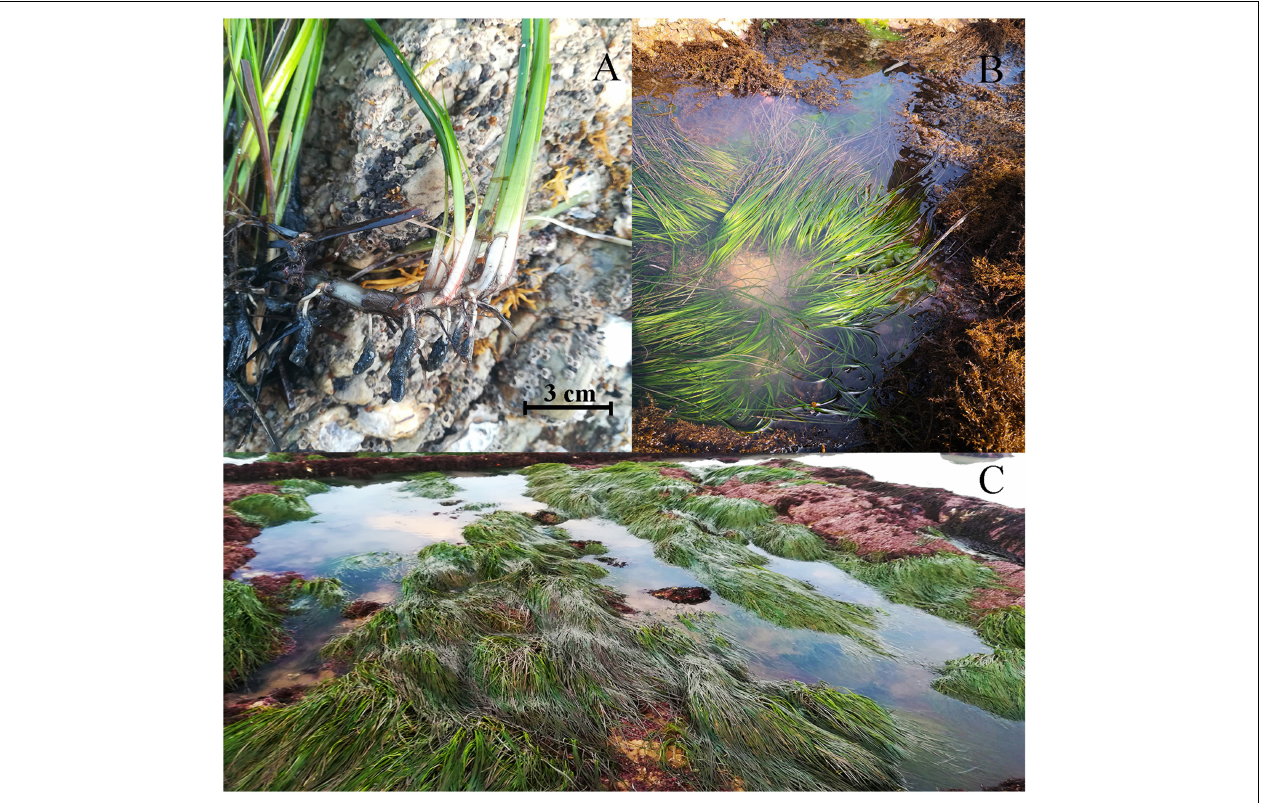
FIGURE 1 | Phyllospadix iwatensis , characterized by reddish-brown hairy fibers at the base of the plant and a well-developed root system (A) , is naturally distributed in the rocky intertidal zone and can form vast “underwater meadows” (B,C)